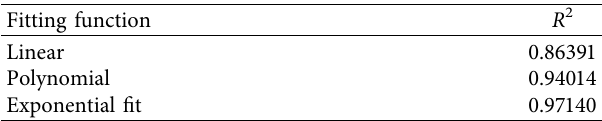
Figure 9: Relationship between E S and moisture content. Table 5: Fitting functions and their related R 2 for determining the best relation between E S and moisture